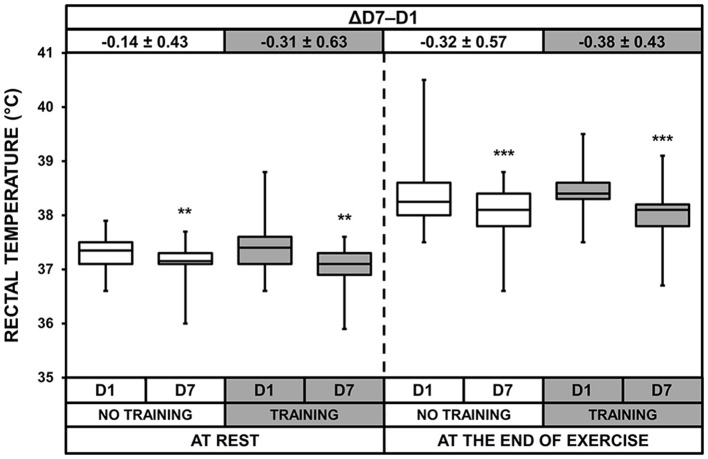
Box-and-whisker plots for rectal temperatures of the No Training and Training groups before (D1) and after (D7) heat acclimatization, at rest and at the end of exercise. The box encompasses the 25–75% quartiles, and the median is represented by the horizontal line within the box. The whiskers extend to the highest and lowest values. Values shown above the boxes, at the top of the plot, correspond to the differences (mean ± SD) between D7 and D1. Significantly different from D1, **p < 0.01; ***p < 0.001.